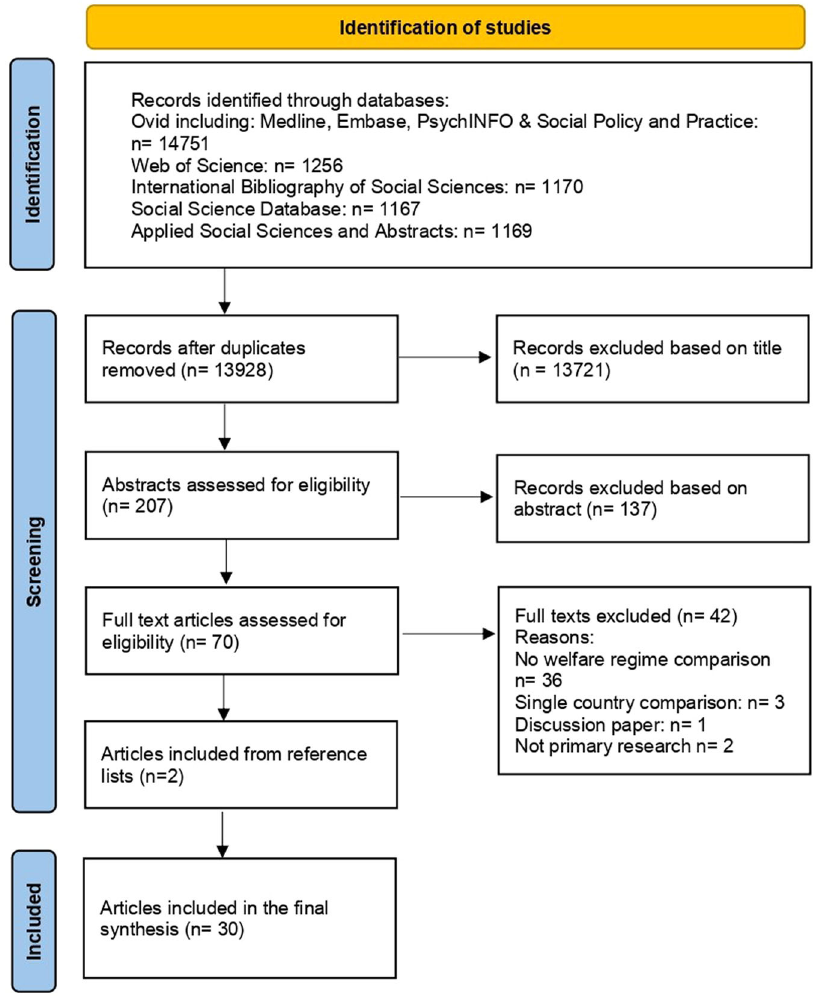
Fig. 1 PRISMA 2020 fl ow diagram illustrating study selection and review